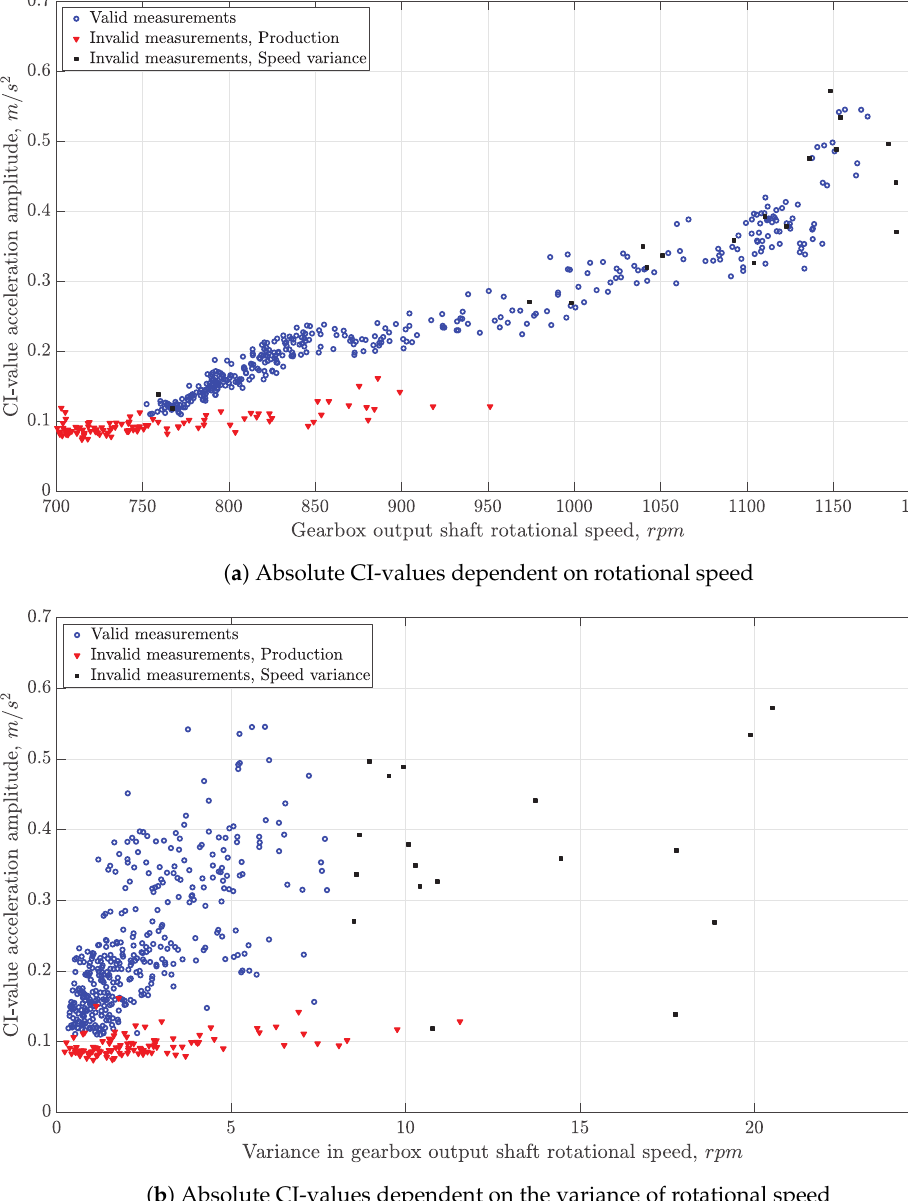
Figure 4. Absolute CI-values dependent on rotational speed in ( a ) and variance in rotational speed in ( b ). CI-values filtered out with respect to the generator not producing in red and CI-values filtered out with respect to high variance in rotational speed in